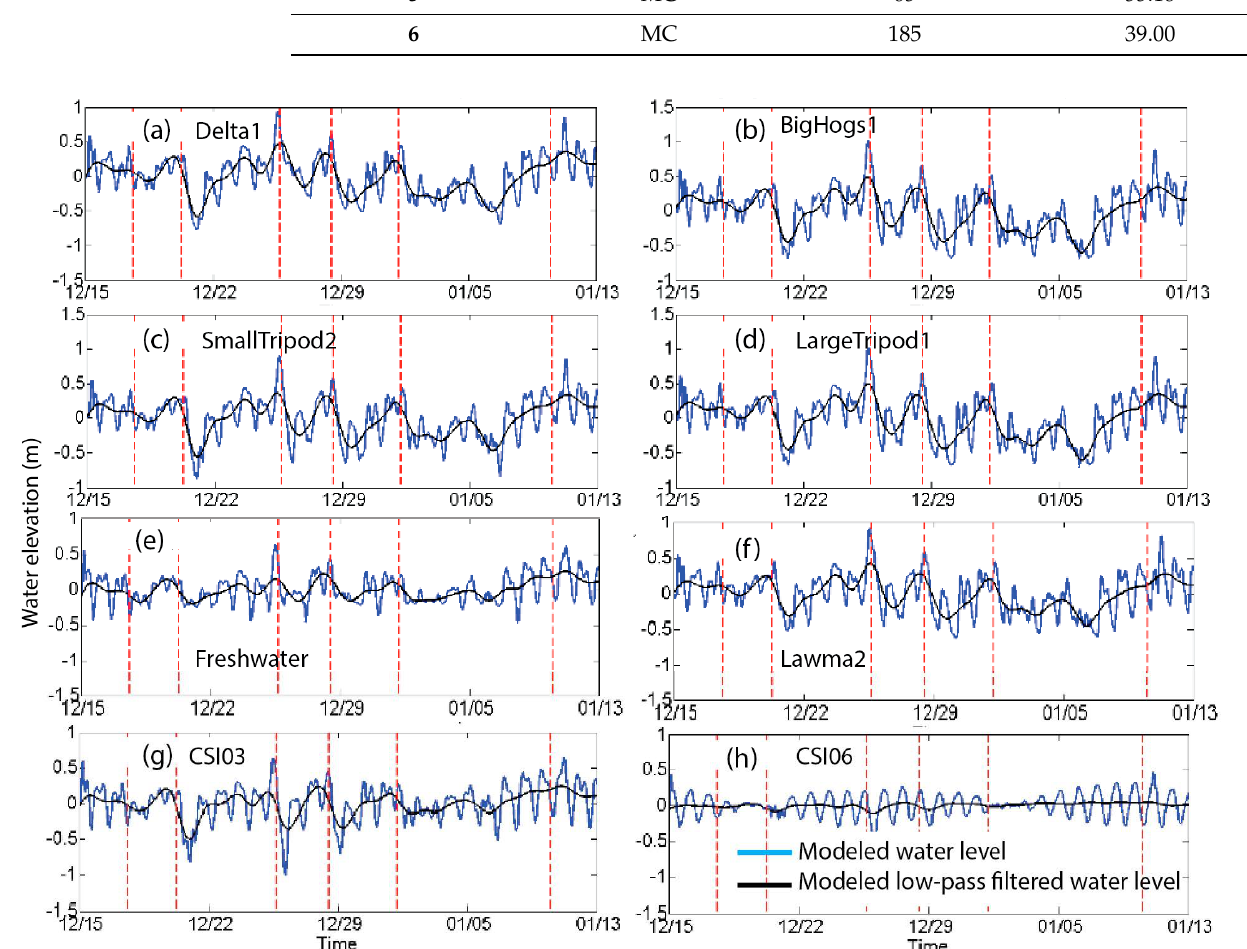
Figure 5. Modeled water levels at eight stations. Subplots ( a – h ) are water level at Delta 1, BigHogs1, SmallTripod2, LargeTripod1, Freshwater, Lawma2, CSI03, and CSI06, respectively. The low-pass filtered results are also shown. The red dashed lines indicate the timing of the frontal passage. Note that the maximum water fluctuation (maximum minus minimum around the frontal passage time) occurred right at the third frontal passage.